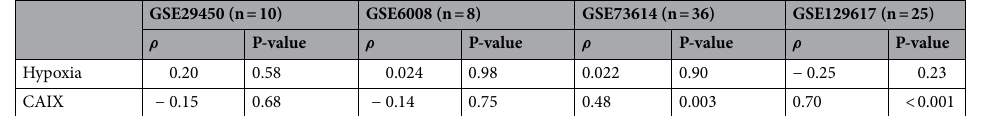
Table 1. Spearman rank correlation test for the relationship between Log-CD8A expression and hypoxia score (first row) and CAIX (second row) obtained from four NCBI